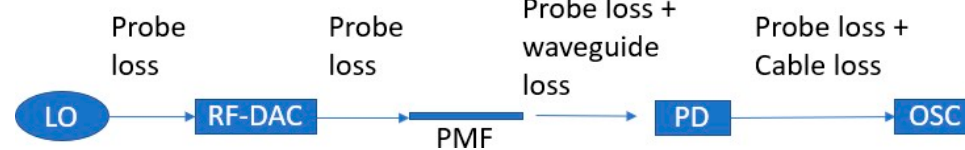
Figure 18. Eye diagrams from the demodulated PAM-4 signal. ( a ) 11 GBaud signal. BER < 10 − 12 . ( b ) 12 GBaud signal. BER = 2.8 × 10 − 12 . ( c ) 15 GBaud signal. BER = 4.3 × 10 − 10 .